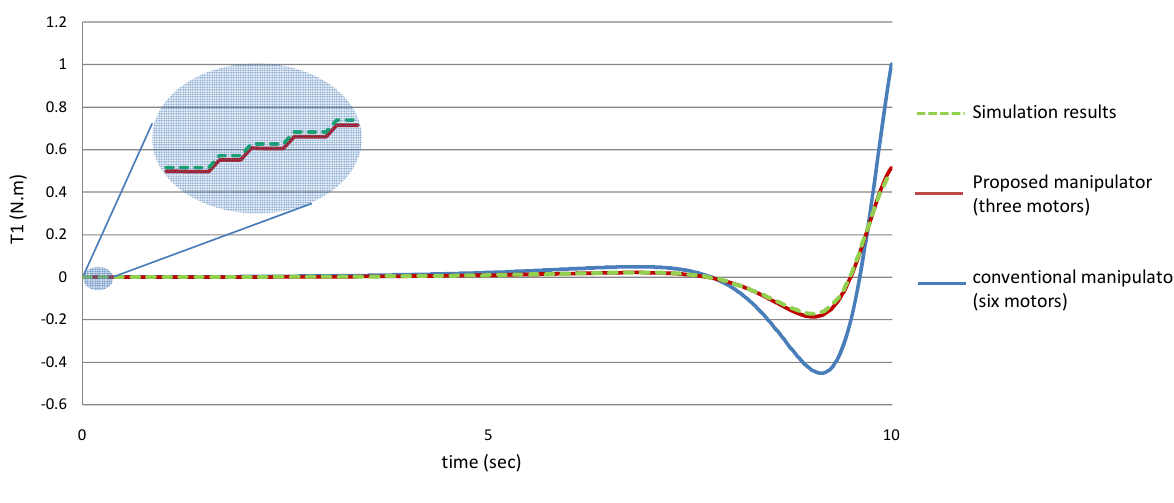
Figure 20. The torque of the first joint